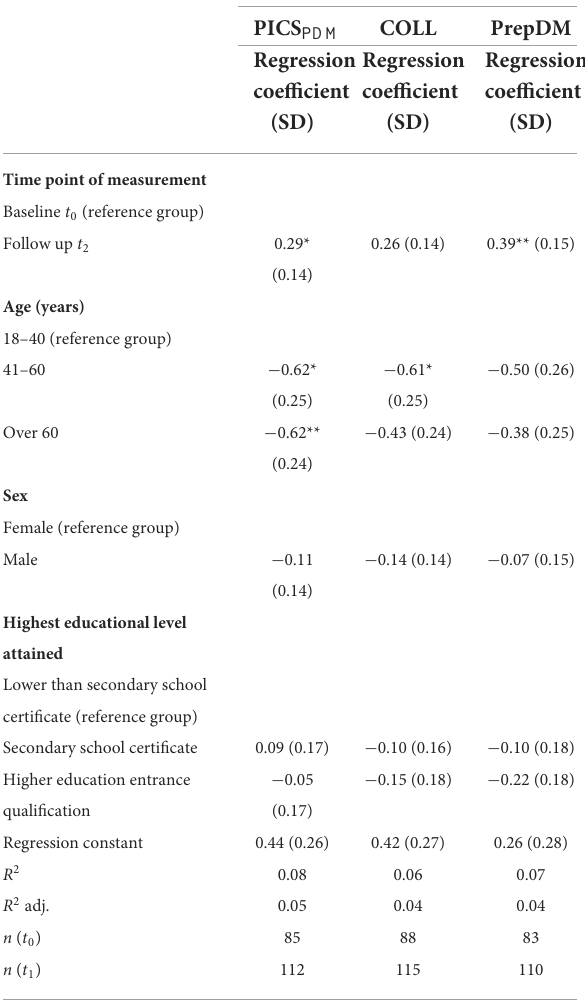
TABLE 3 Multiple linear regression analysis of the effect of time point of measurement, age, sex, and educational level on the primary endpoint “patient participation in decision making” (PICS PDM ) and on secondary endpoints CollaboRATE and